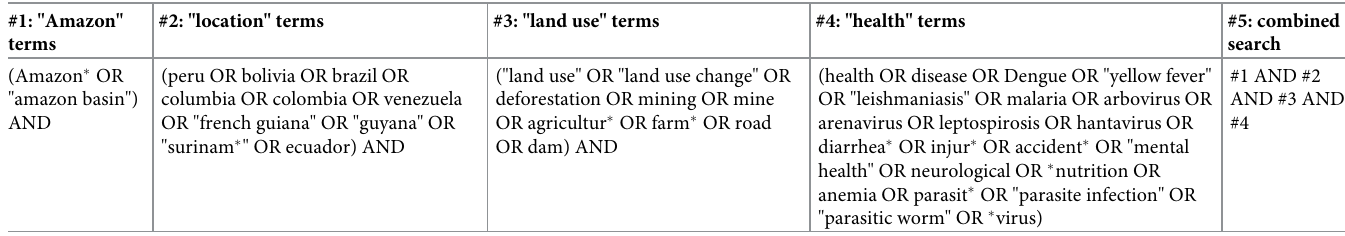
Table 1. Keywords (with synonyms) and syntax used for literature search.